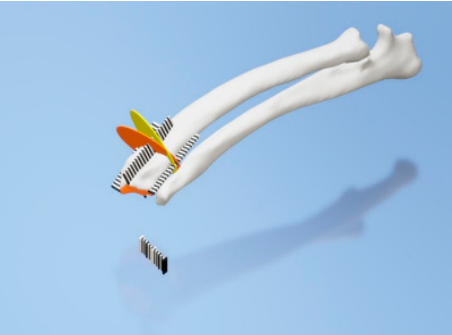
Figure 9. Rulers were attached to the cranial, caudal, medial, and lateral bone model surfaces. The orange and yellow plates show the osteotomy target plane. The black and white striped bar is made 1 mm against each space to indicate the distance from the edge of the joint surface.